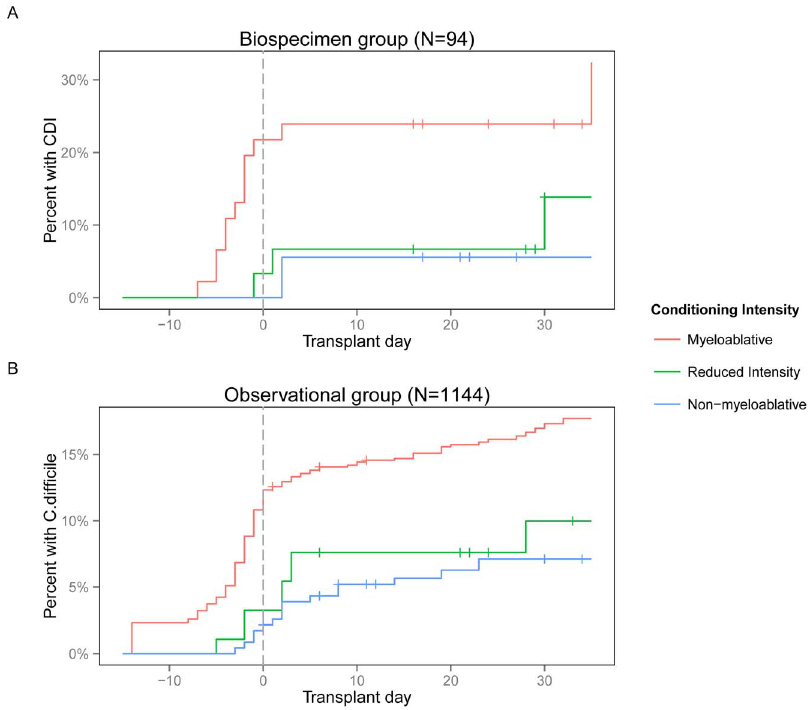
Figure 2. Kaplan-Meier plot of CDI during allo-HSCT. Patients receiving greater intensity conditioning regimens were more likely to develop CDI. A , Biospecimen group (N=94). B , Observational group (N=1144). doi:10.1371/journal.pone.0090158.g002 Clinically, we found that the diagnosis of early transplant CDI was common and patients appeared to respond rapidly to antibiotic therapy. Early allo-HSCT CDI correlated with high Table 2. Univariate predictors of CDI in the biospecimen group and observational group, by Cox proportional hazards regression.